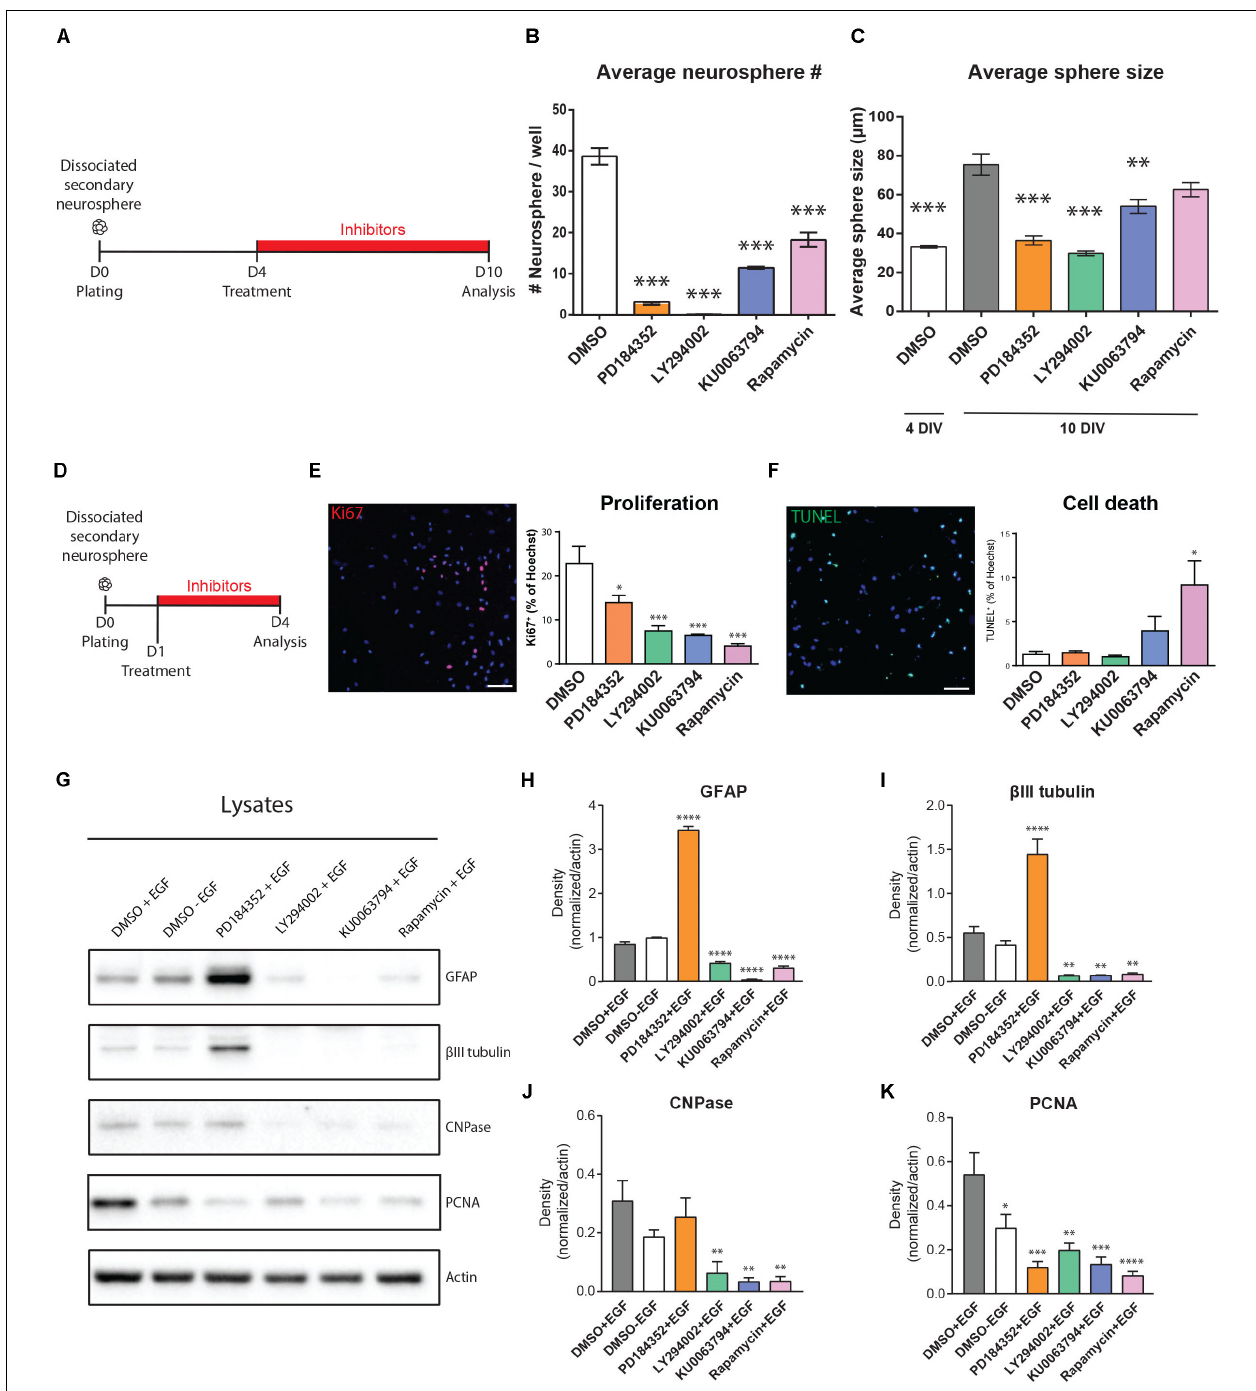
FIGURE 3 | EGF-induced signaling modules show both overlap and selectivity in their regulation of NSPC proliferation, survival, and differentiation. (A–C) Effects of inhibitors on neurosphere growth. (A) Paradigm for neurosphere formation assay. (B) Numbers of neurospheres > 70 microns in size ( n = 3/group). (C) Average size of colonies at the start of treatment (4 DIV) and after 6 days of treatment (10 DIV) ( n = 3/group). One-way ANOVA with Dunnett’s post hoc test for (B,C) . (D–K) Effects of inhibitors on NSPC proliferation, survival and differentiation. (D) Paradigm for adherent NSPC culture assays. (E) Representative micrograph of proliferating cells (Ki67, pink) counterstained for total nuclei (Hoechst, blue) with quantification at right ( n = 3/group). (F) Representative micrograph of dying cells (TUNEL, green) counterstained for total nuclei (Hoechst, blue) with quantification at right ( n = 3/group). One-way ANOVA with Dunnett’s post hoc test. (G) Representative Western blot of inhibitor-treated NSPCs probed for the astrocytic marker GFAP, neuronal marker β III-tubulin, oligodendrocytic marker CNPase, proliferation marker PCNA, and loading control Actin, with (H–K) their respective densitometric quantifications normalized to Actin ( n = 4/group). One-way ANOVA with Dunnett’s post hoc test. Scale bar represents 80 µ m in (E,F) . ∗ p ≤ 0.05; ∗∗ p ≤ 0.01; ∗∗∗ p ≤ 0.001; ∗∗∗∗ p ≤